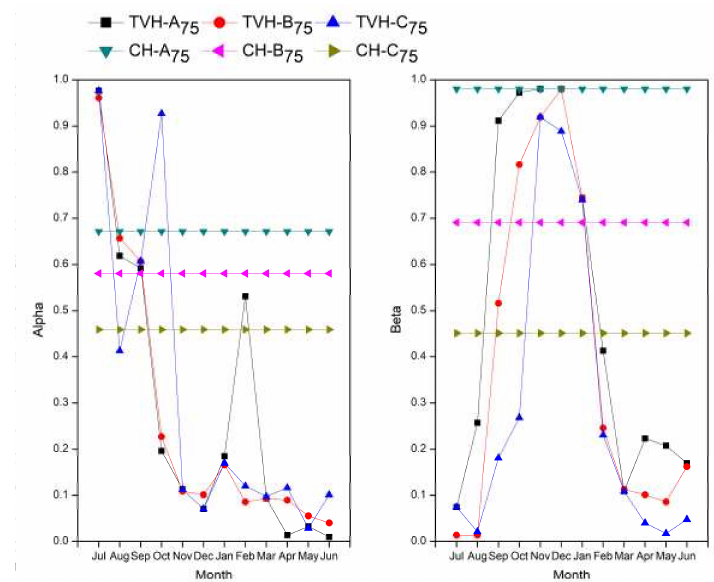
Figure 6. Time-varying hedging (TVH) and constant hedging (CH) parameters (alpha and beta) for two-point hedging policy—A comparison between the selected pareto-optimal solutions for 75% demand level.